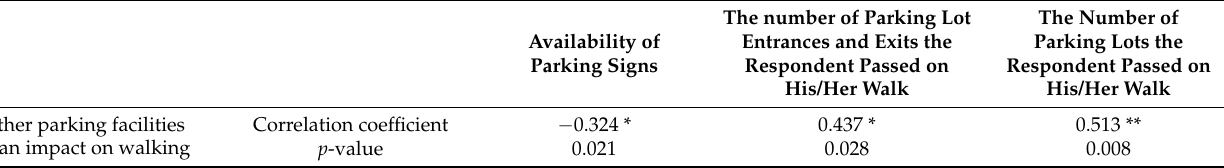
Table 8. Results of the analysis of factors affecting pedestrians by parking